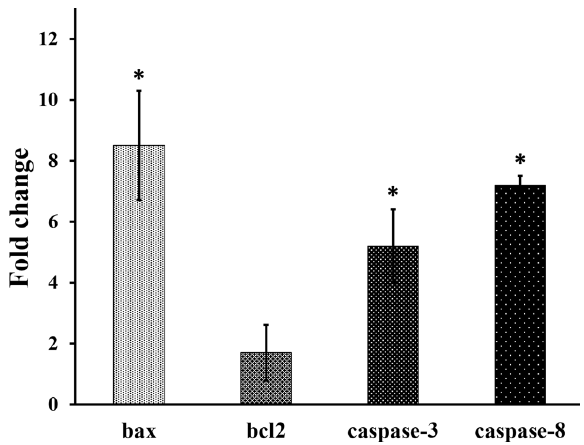
Fig. 6 The gene expression of sw-1736 thyroid cancer cells after the treatment of 7 µl of the curcumin niosome nanoparticles for 72 h. The higher expression of bax, caspase-3 and caspase-8 in the treated group con fi rms the apoptotic impact of the nanoparticles. Moreover, the fold change of bcl2 as an inhibitor of cell death near to 1 shows the non- activation of this gene by the nanoparticles. The star indicates the signi fi cant difference between the groups ( P value <